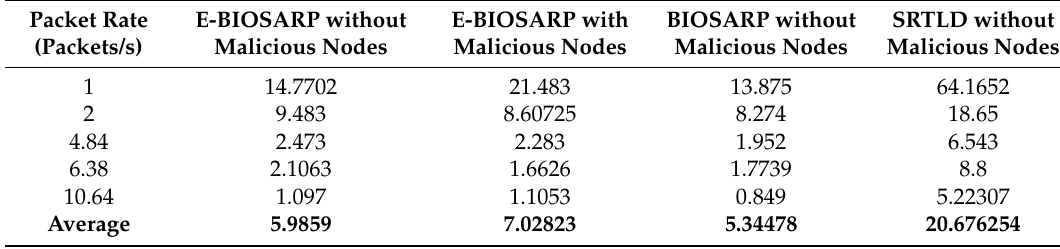
Table 8. Data packet overhead